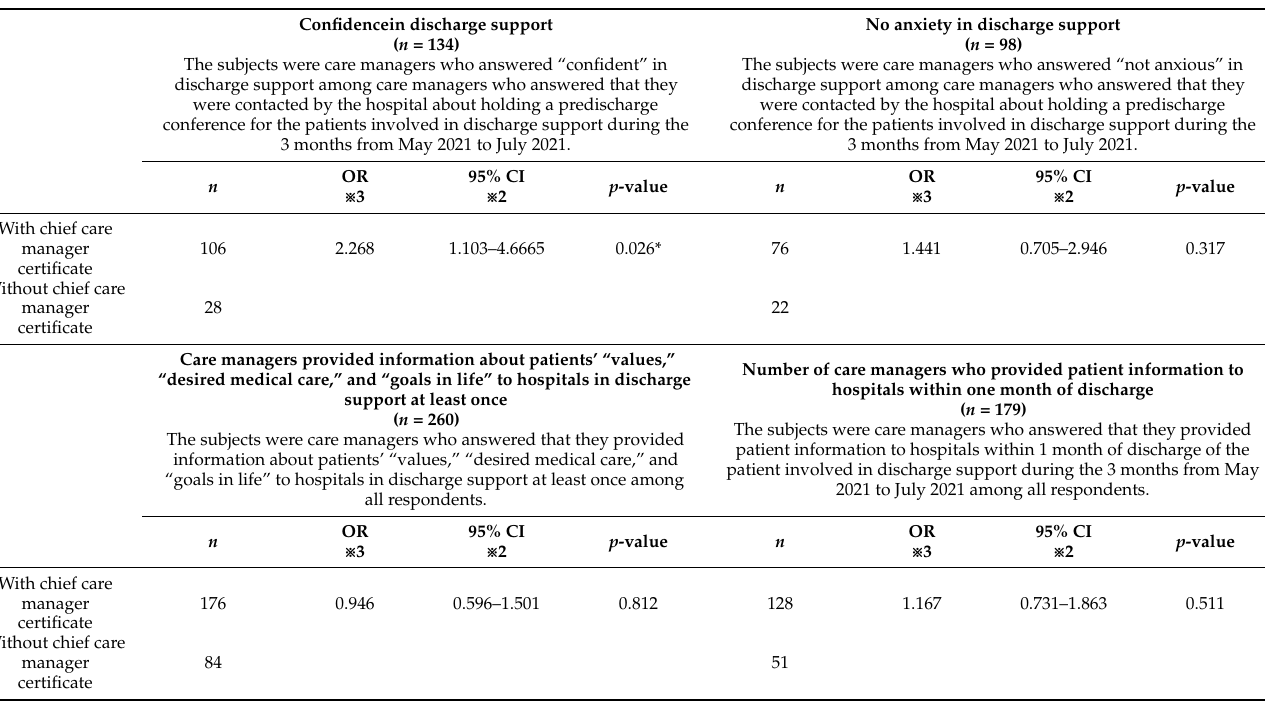
Table 8. Association between the chief care manager certification status and discharge support practice, confidence, and